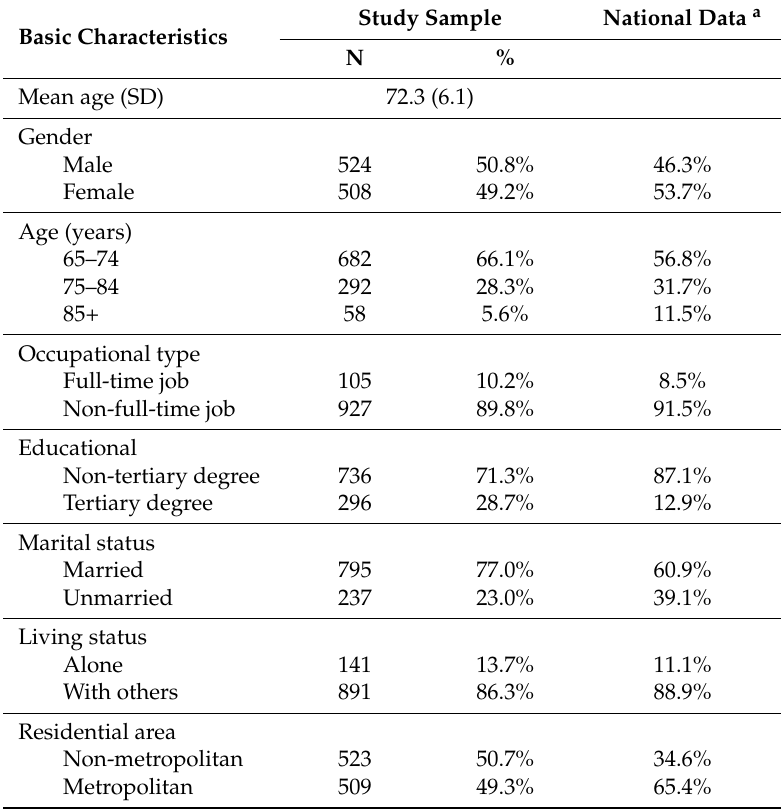
Table 1. Basic characteristics of all respondents (N =